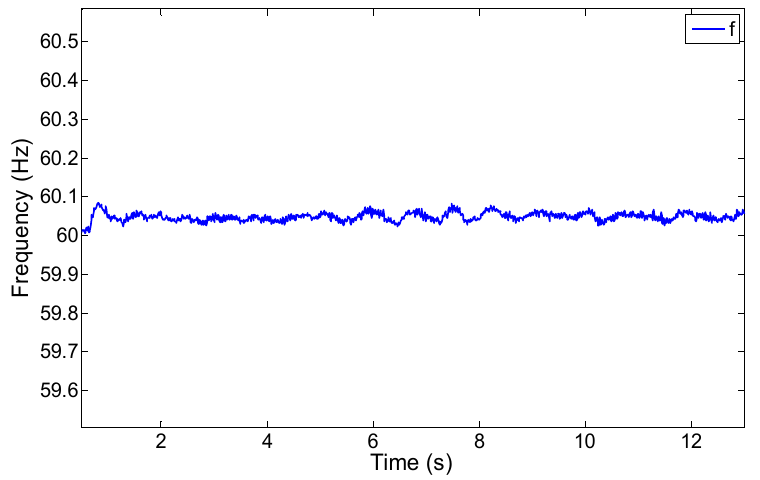
Figure 23. Frequency was slightly higher than its nominal value.